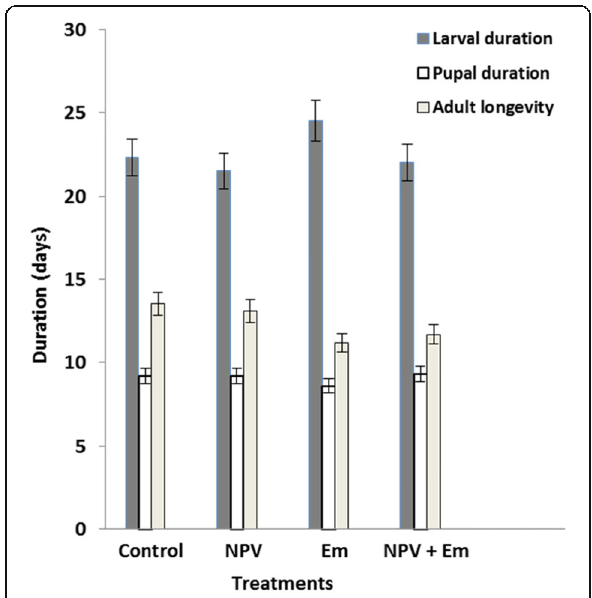
Fig. 7 Average larval duration, pupal duration, and adult longevity of Spodoptera littoralis stages previously treated as 2nd instar larvae with Spli MNPV Em 0.05 ppm, Em 1 × 10 4 BIPs and Em 0.05 ppm +